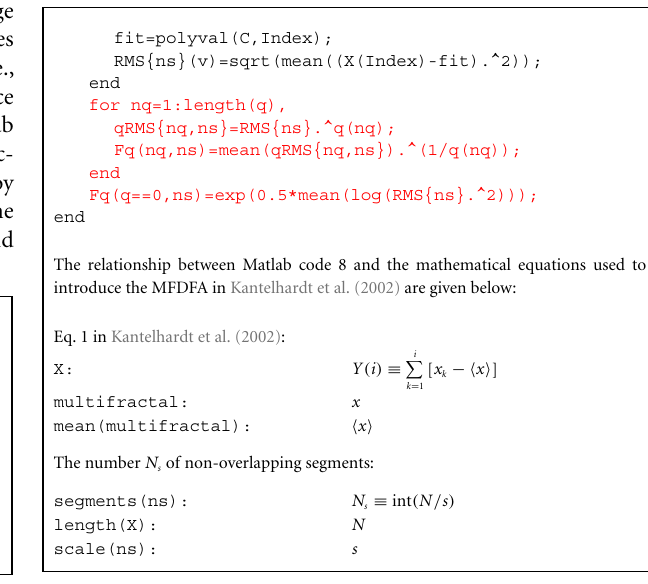
FIGURE 7 |An illustration of qRMS{1} computed by Matlab code 7. qRMS{1} is the q -order of the local fluctuateons (i.e., RMS{1} ) and are the building block of the overall q -order RMS (i.e., Fq in Matlab code 7). qRMS{1} is represented for the monofractal ( green traces ) and multifractal ( blue traces ) time series.The negative q -order ( q =− 3 and − 1) amplifies the segments in the multifractal time series with extreme small RMS{1} whereas positive q -order ( q = 3 and 1) amplifies